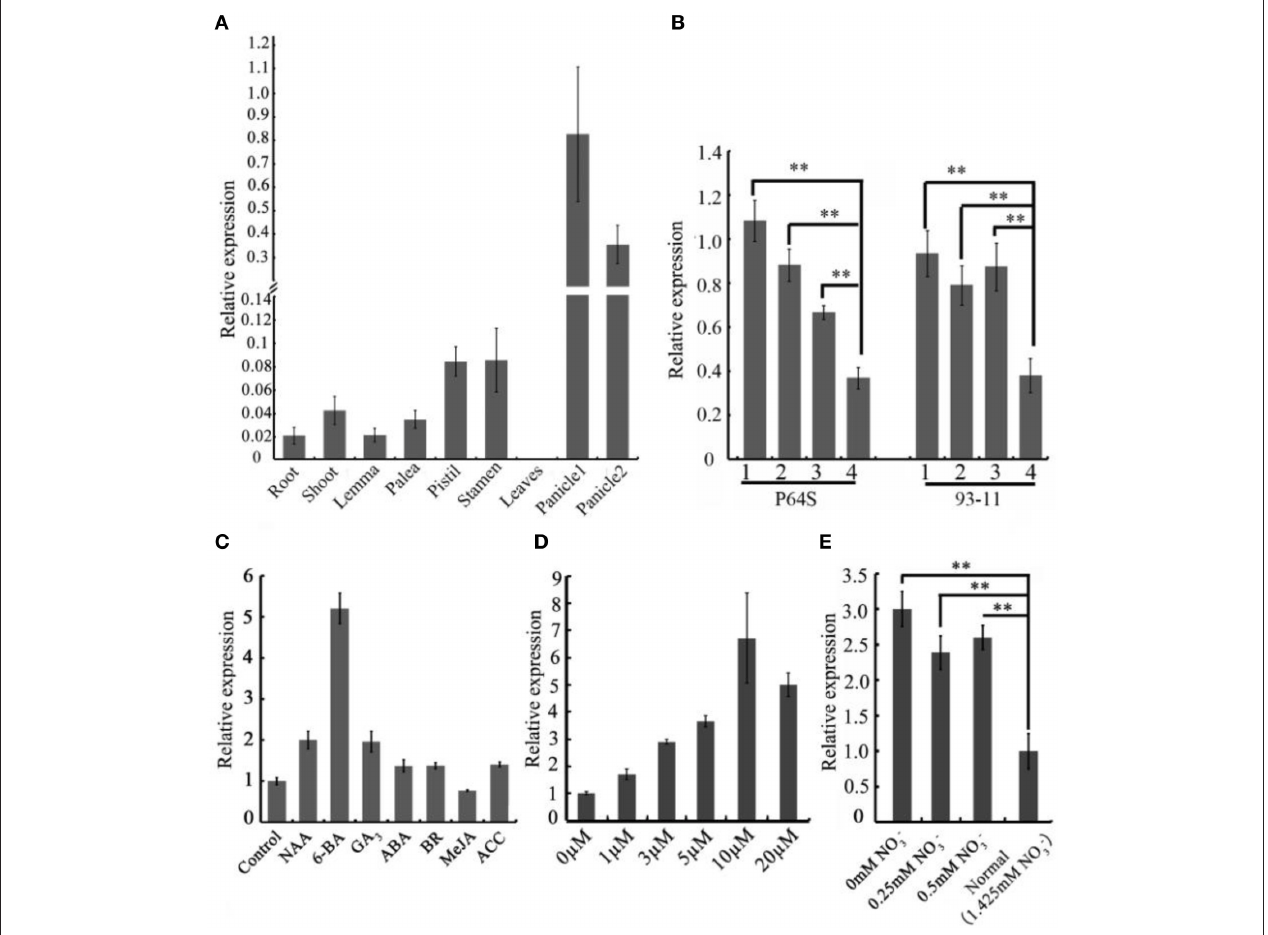
FIGURE 3 | The spatio-temporal expression patterns of OsCEP6.1. (A) Quantitative RT-PCR analysis revealed that OsCEP6.1 was highly expressed in the panicle among nine tissues of ZH17, including root, shoot, lemma, palea, stamen, pistil, leaf and panicles. panicle1: 40–50mm panicles; panicle2: panicles at heading stage. (B) Quantitative RT-PCR analysis showed that the expression level of OsCEP6.1 was significantly higher at the first three stages of panicles compared with the heading stage in both P64S and 93–11. 1: < 5mm panicles; 2: 10–15mm panicles; 3: 40–50mm panicles, 4: panicles at heading stage. (C) The expression level of OsCEP6.1 was significantly induced by 6-BA application. The 6-day-old seedlings were treated with different phytohormones (10 µ M NAA, 10 µ M 6-BA, 10 µ M GA, 100 µ M ABA, 1 µ M BR, 100 µ M MeJA, and 50 µ M ACC). (D) The expression patterns of OsCEP6.1 was significantly induced under 10 µ M 6-BA compared with other concentration applications. The 6-day-old seedlings were treated with 0, 1, 3, 5, 10, and, 20 µ M 6-BA. (E) The expression level of OsCEP6.1 was increased under low nitrate concentration. The 6-day-old seedlings were transferred to the nutrient solutions with different nitrate concentration, and the root was collected 3 days after transfer. ** P < 0.01